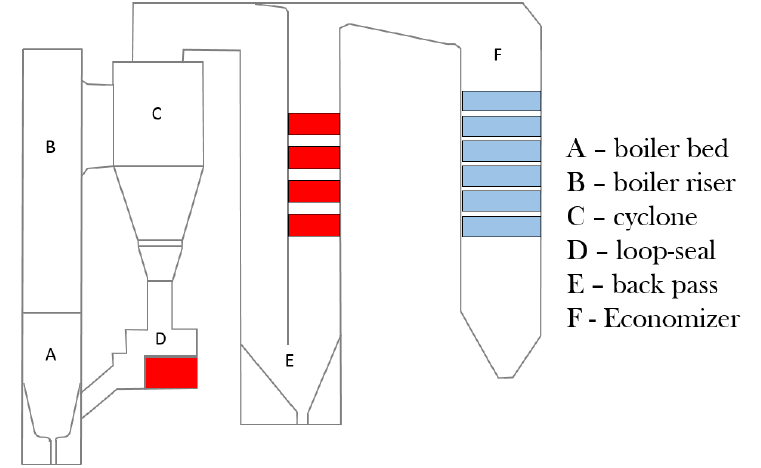
Figure 1. Circulating fluidized bed